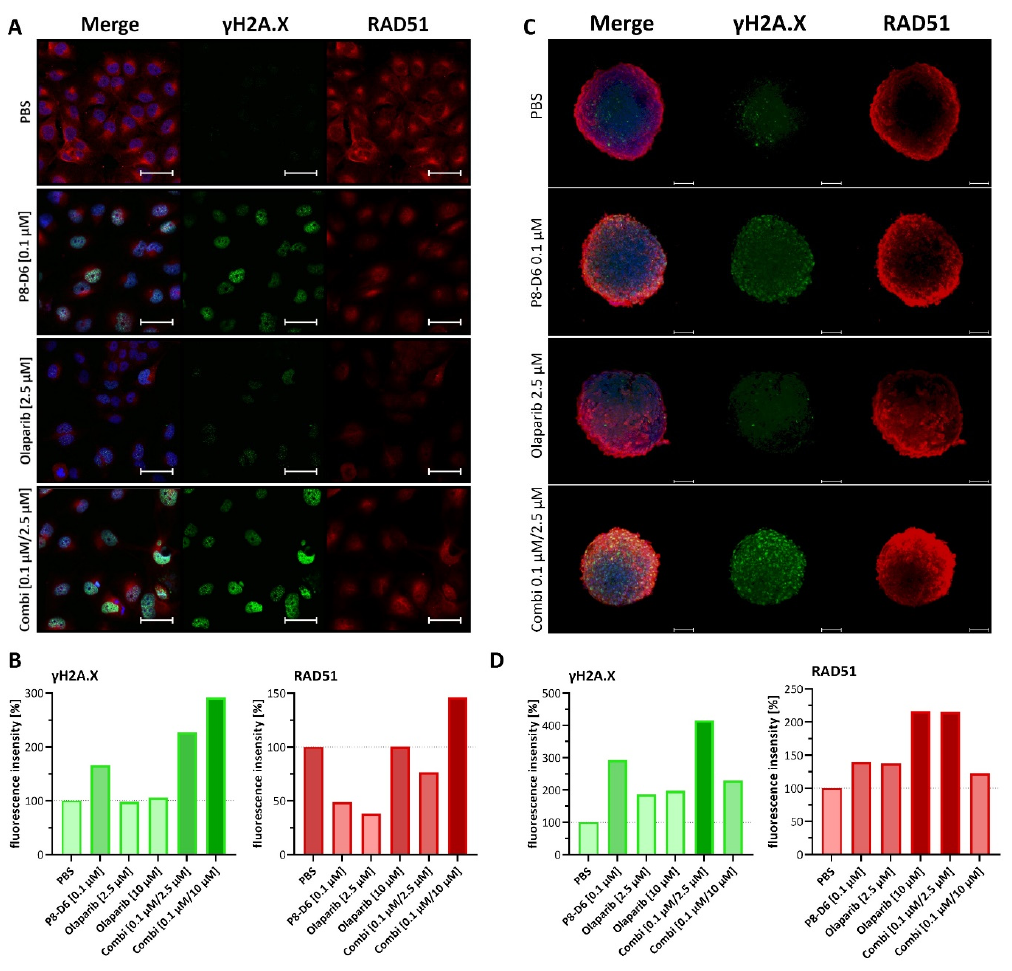
Figure 7. Olaparib potentiates γ H2A.X and RAD51 recruitment for strand break induced by P8-D6 in OvCar8. ( A ) Immunofluorescence images of OvCar8 2D monolayer: DAPI-stained nuclei (blue), γ H2A.X (green) and RAD51 (red) after treatment with olaparib and/or P8-D6; scale bars, 50 µ m. ( B ) The intensity of the γ H2A.X and RAD51 signal in relation to DAPI in OvCar8 2D monolayer after treatment. ( C ) Confocal fluorescence z-stack images of OvCar8 spheroids were obtained with immunostaining against γ H2A.X, RAD51 and Hoechst 33342. Spheroids were treated with olaparib and/or P8-D6, permeabilized with glycerol, followed by antibody staining; scale bars, 100 µ m. ( D ) γ H2A.X and RAD51 fluorescence intensities of different treatments were compared between different